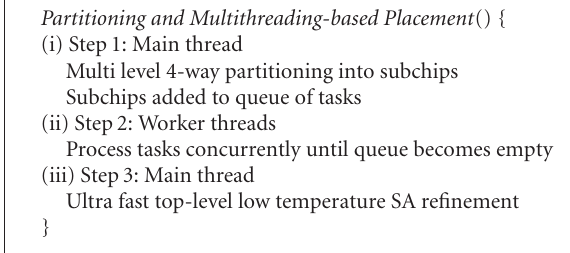
Algorithm 1: Pseudocode of the proposed multithreading-based parallelization algorithm.